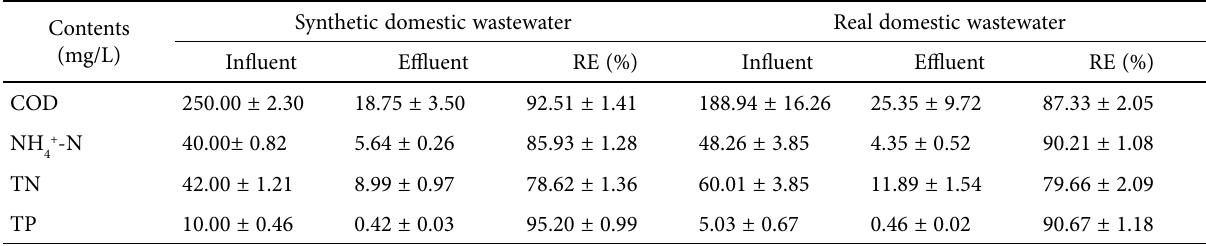
Table 3. Averaged concentrations of COD, NH when synthetic or real domestic